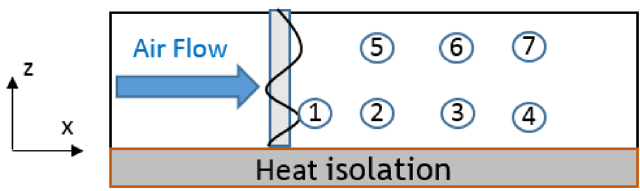
Fig. 5 Schematic process for particle size variation test from the side